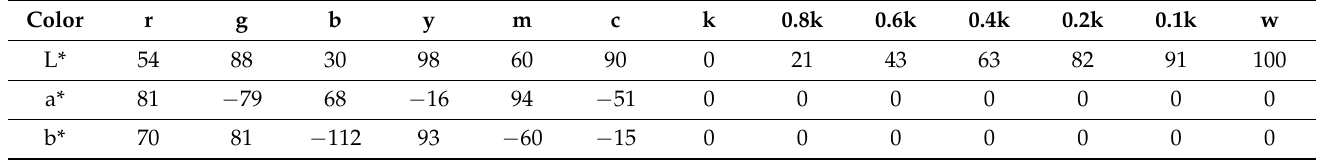
Table 1. Color parameters in each sample